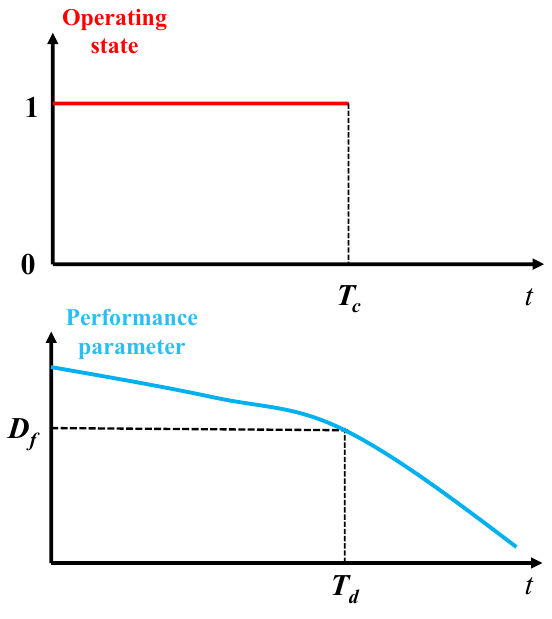
Figure 1. Schematic diagrams of the two failure modes.